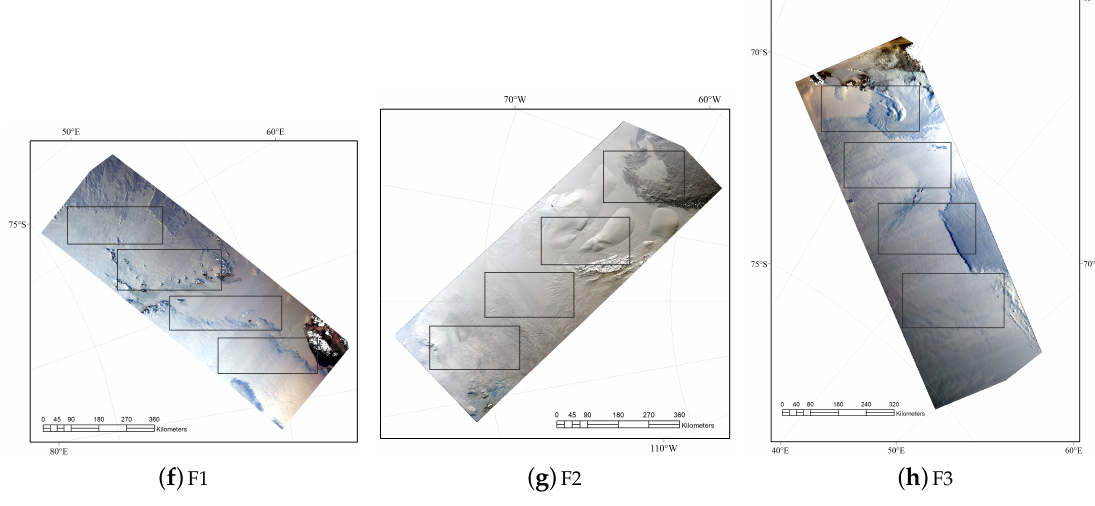
Figure 10. The sub-region locations and ranges. The three images shown are named F1, F2, and F3. The rectangles are the sub-regions of each image, labeled A, B, C, and D, from left to